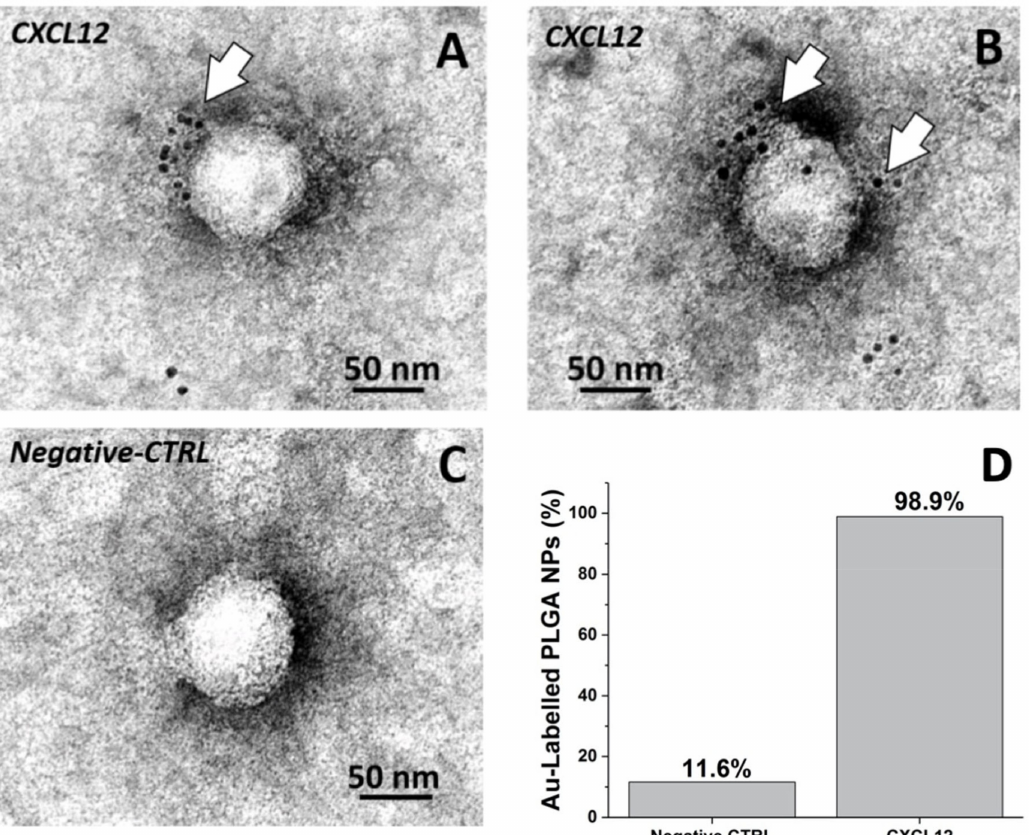
Figure 2. Negative staining EM immunolabeling. Representative images of treated (CXCL12) ( A , B ) and negative control (Negative CTRL) CXCL12-NPs ( C ). White arrows point to the Au nanoparticles conjugated to the secondary antibody decorating the NP surface. ( D ) Columns show the percentage of Ig-Au-decorated CXCL12-NPs in treated and negative control samples. Table 1. Z-average size, polydispersity index (PDI) and Z-potential of non-functionalized NPs